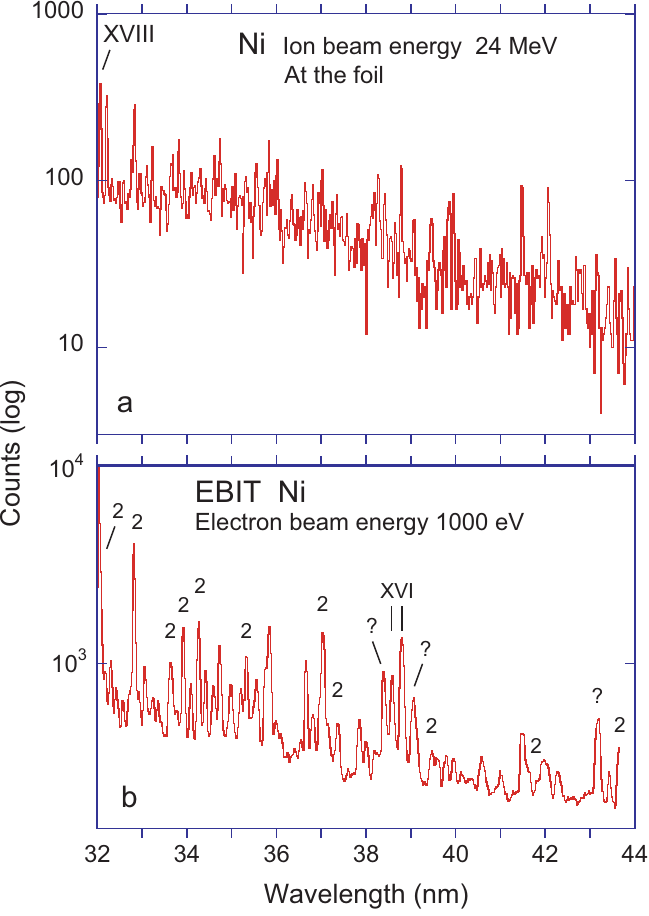
Figure 19. Spectra of Ni in two different light sources. ( a ) Beam–foil spectrum at an ion beam energy of 24 MeV. Line width (FWHM) 0.045 nm. Several of the strongest lines are identified by the spectrum number; ( b ) electron beam ion trap spectrum at an electron beam energy of 1 keV. The flat-field spectrograph setting is the same as used for the spectra in Figures 14 and 15. Line markers with an Arabic ‘2’ indicate second diffraction order images. ( a ) and ( b ) continuation Figure 18a,b, respectively. Line markers with an arabic ‘2’ indicate second diffraction order